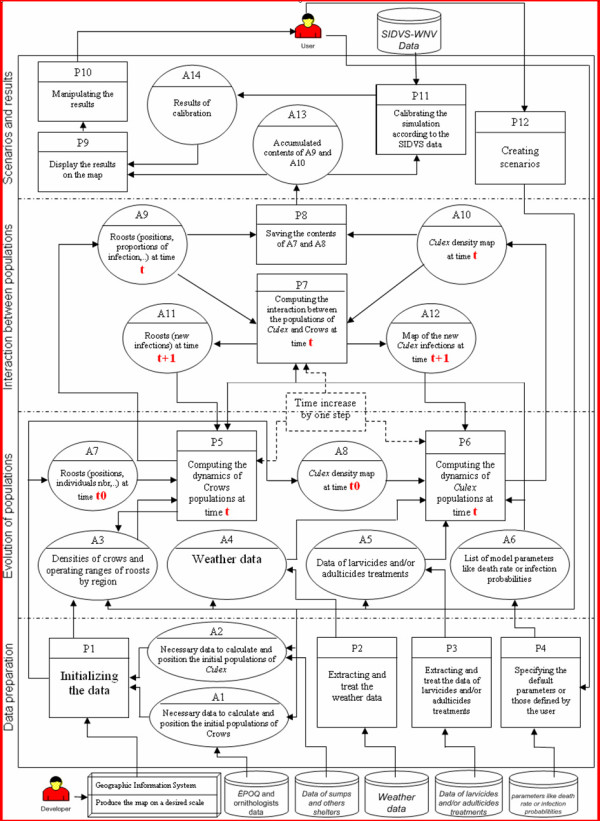
Conceptual architecture of the system (based onEPASmethod[32]).